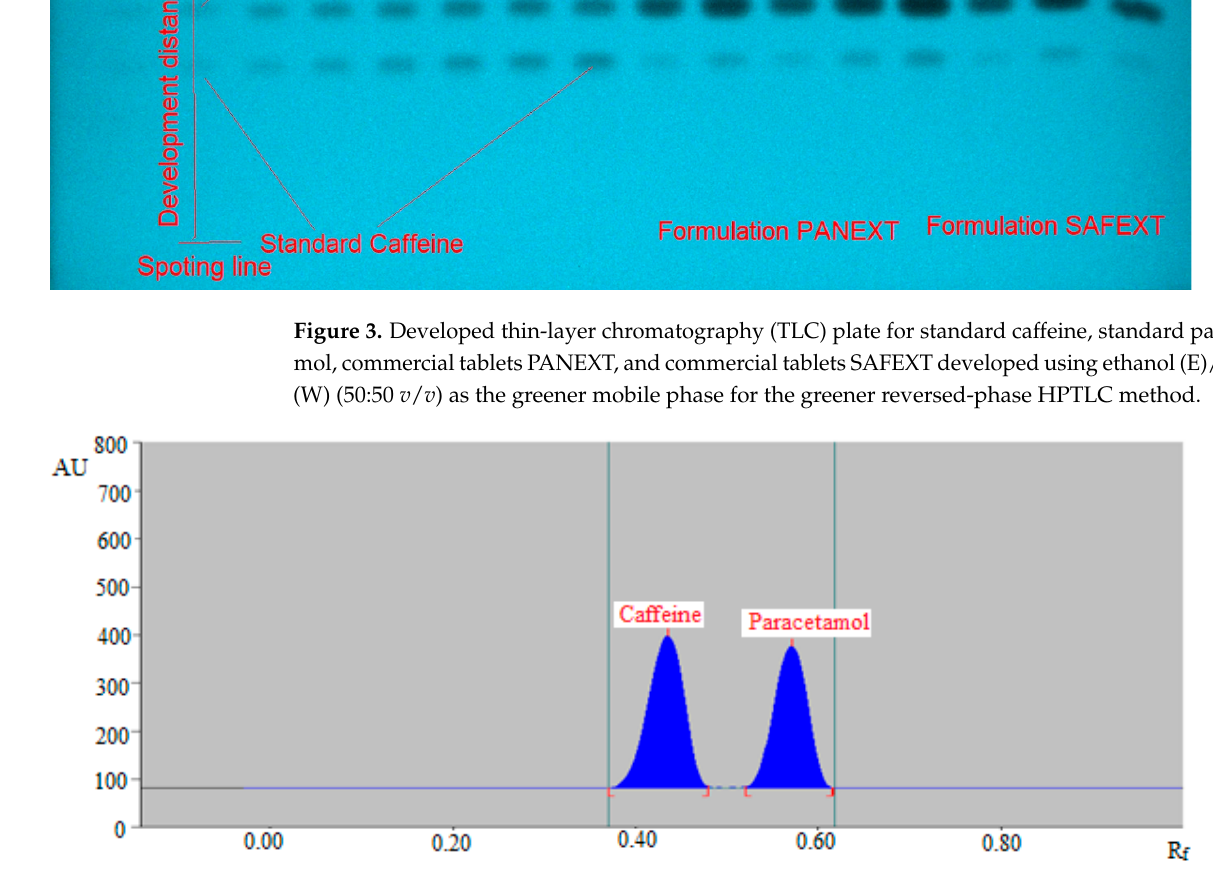
Figure 4. Reversed ‐ phase HPTLC chromatogram of standard caffeine and paracetamol.